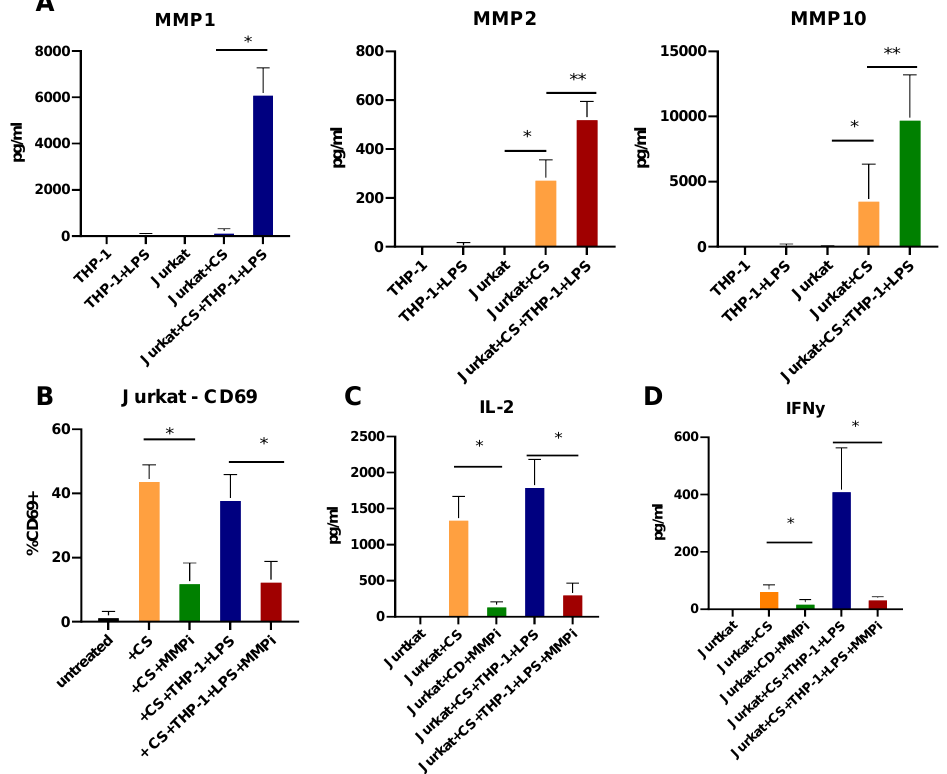
Figure 6. Activated T cells and T cells in co-culture with monocytes produce MMPs and are activated, which are decreased by GM6001 MMP inhibitor where ( A ) MMPs are produced and activated by Jurkat cells activated with a cell stimulation cocktail (CS) or activated in co-culture with THP-1 cells activated with LPS and ( B ) express CD69 as an activation marker that is decreased by cells treated with MMPi, as are ( C ) IL-2 and ( D ) IFN γ production. N = 6, * and ** p < 0.05.